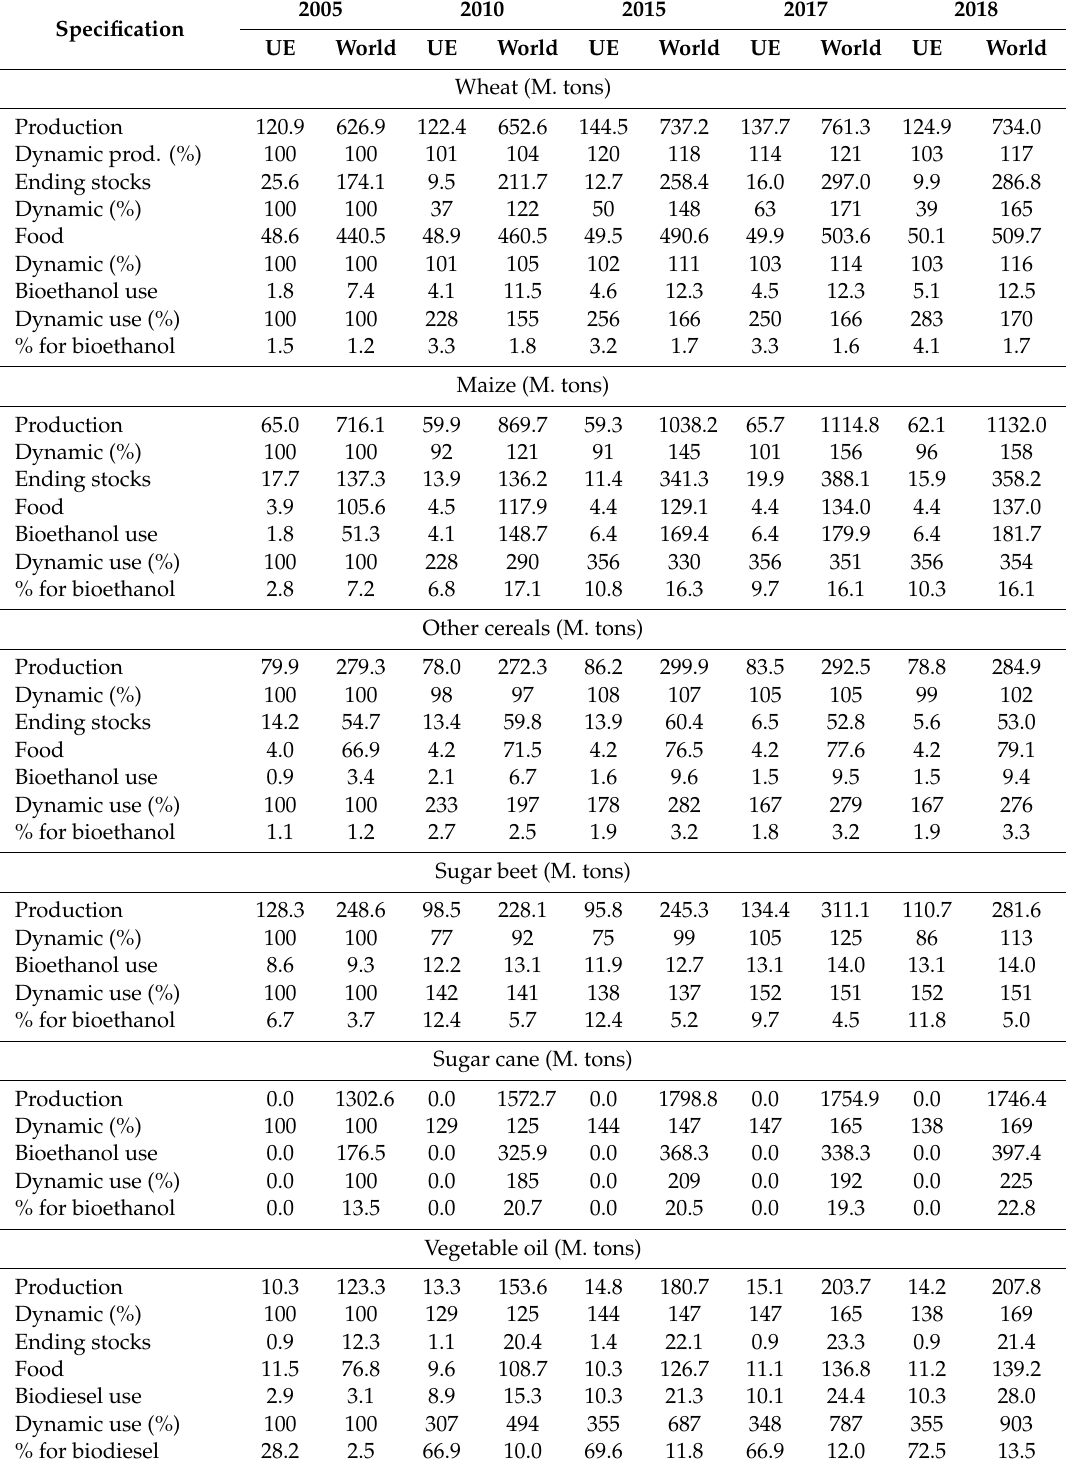
Table 2. Balance of raw feedstocks used for biofuel